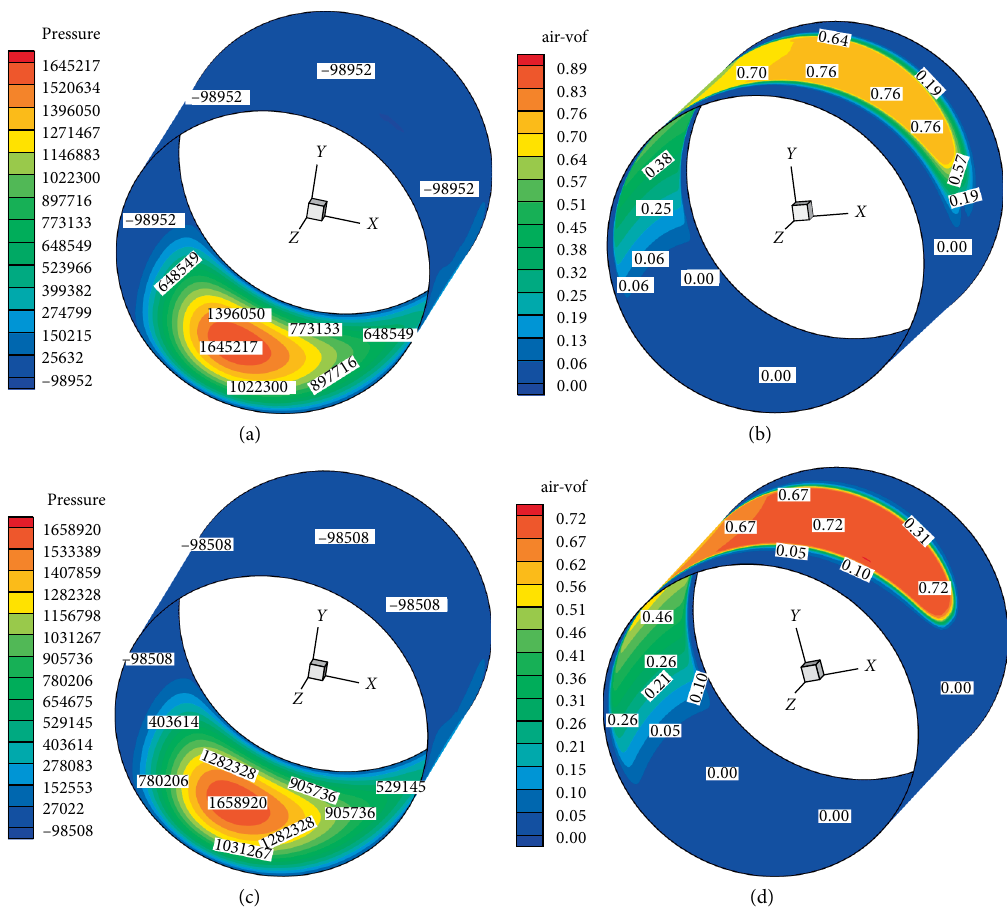
= 2000 r/min). (a) w g =1.5 × 10 −7 pressure distribution. (b) w g = 1.5 × 10 −7 𝑛